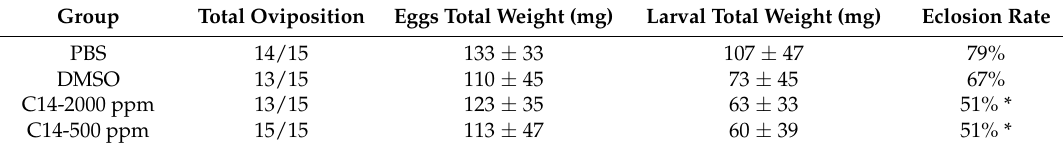
Table 2. Inhibitory effects of compound 14 on Rhipicephalus microplus fully engorged females by